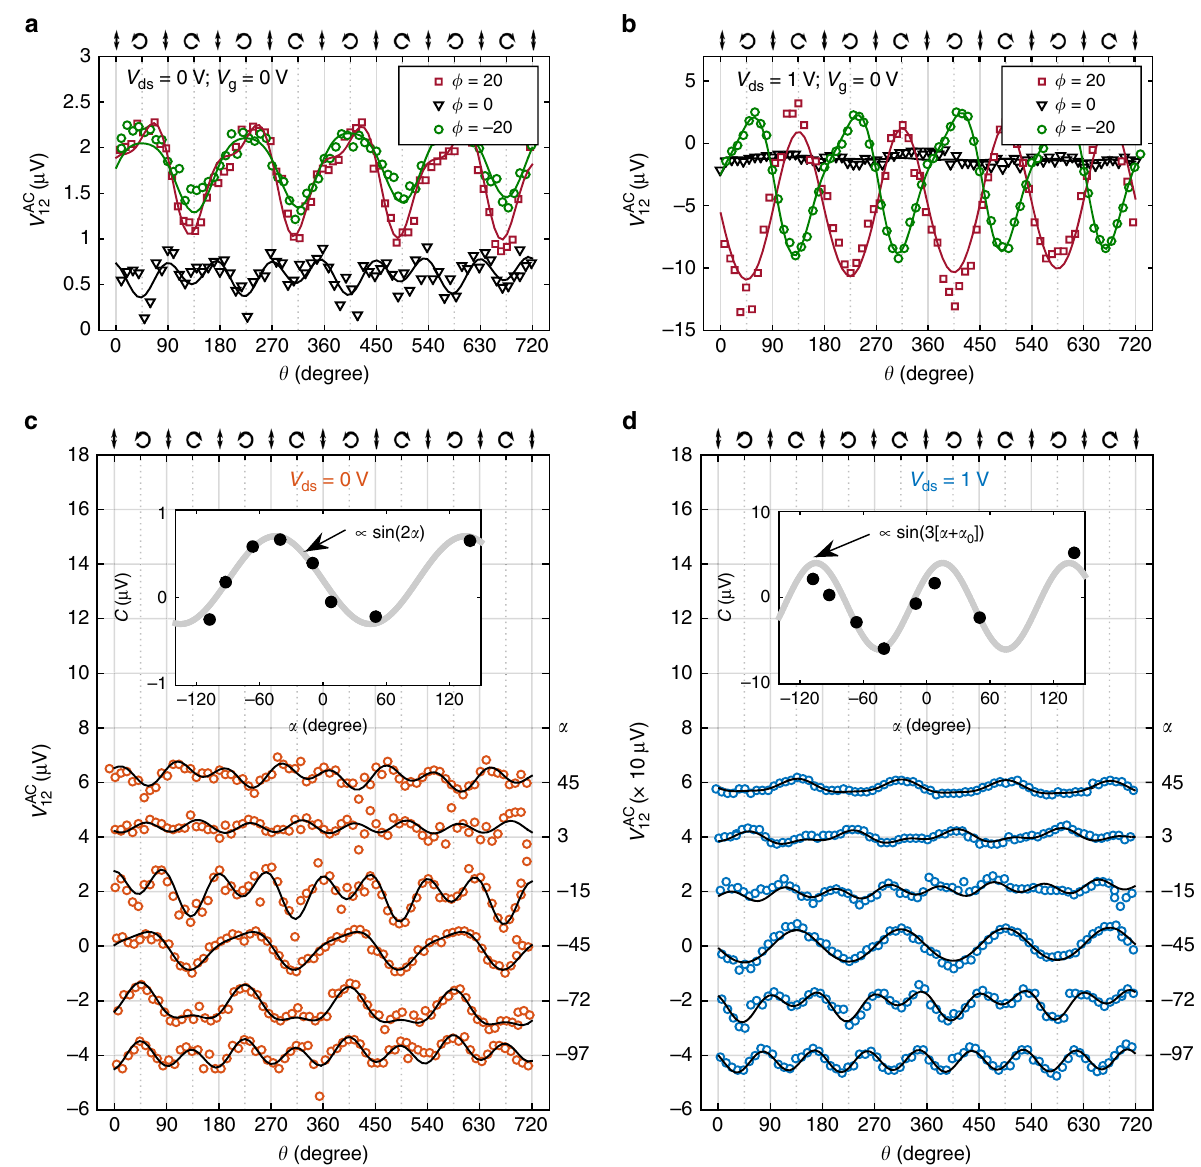
Fig. 4 Effect of the illumination angle on the CPC amplitude, C . a Helicity-dependent photovoltage measured at V ds = 0 V, V gate = 0 V and λ = 785 nm for three different illumination incidence angles, ϕ = − 20°, 0° and 20°. The azimuthal angle, α , is fi xed at α = 45°. b Same as a for V ds = 1 V. c Helicity- dependent photovoltage at different azimuthal angles, α , with V ds = 0 V and ϕ = 20°. For clarity, the helicity-independent background has been removed and the plots have been shifted vertically in steps of 2 μ V. Inset: CPC amplitude, C , extracted by fi tting the measured photovoltage to Equation 1, as a function of α . We observe that C changes proportionally to sin(2 α ). d Same as c for V ds = 1 V. In this case, C changes proportionally to sin(3 α